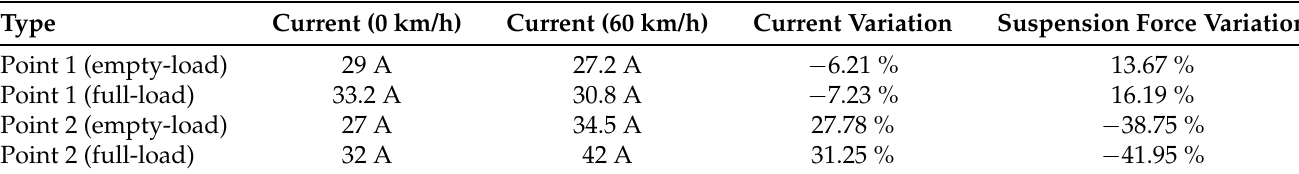
Table 2. Influence of eddy current effect on suspension system.